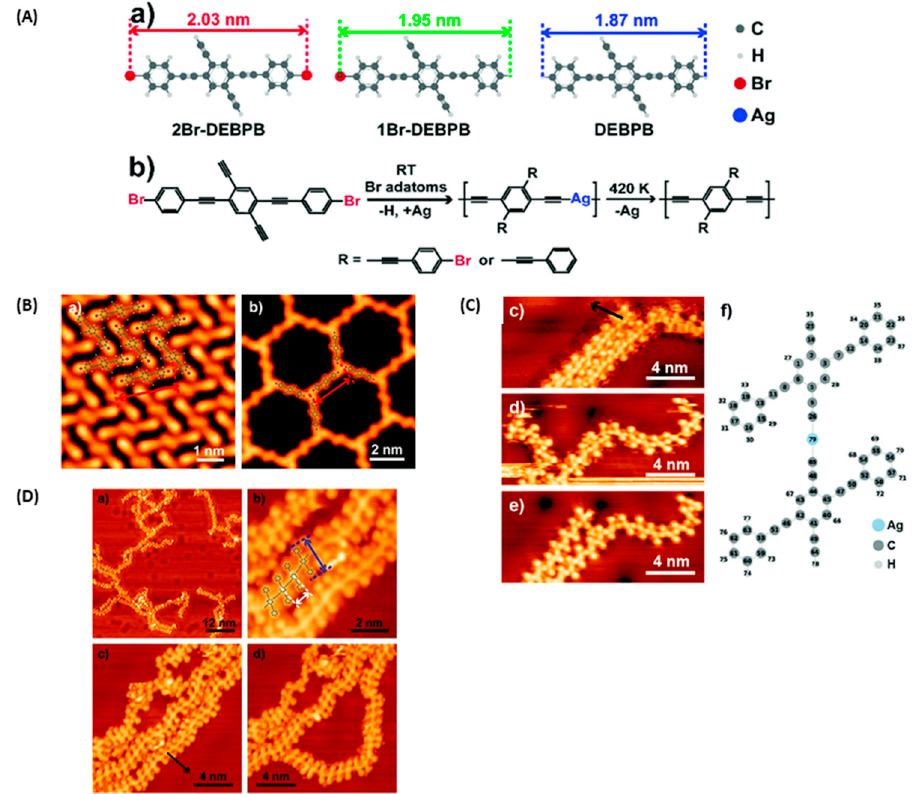
Figure 22. ( A ) Polymerization of 2,5-diethynyl-1,4- bis (4-bromophenyl-ethynyl)benzene (2Br-DEBPB) on Ag(111) substrates and chemical structures of 1-((4-bromophenyl)ethynyl)-2,5-diethynyl-4- (phenylethynyl)benzene (1Br-DEBPB) and ((2,5-diethynyl-1,4-phenylene)bis(ethyne-2,1-diyl))dibenzene (DEBPB). ( B ) STM images of the supramolecular phases obtained by annealing the surface at RT temperature for 30 min. ( C ) STM images of the coordination polymer obtained by annealing the surface at RT temperature for 10.5 hours. 4) Covalent polymer chains obtained by annealing the Ag(111) surface at 410K. Reproduced from [124] with permission from The Royal Society of Chemistry.